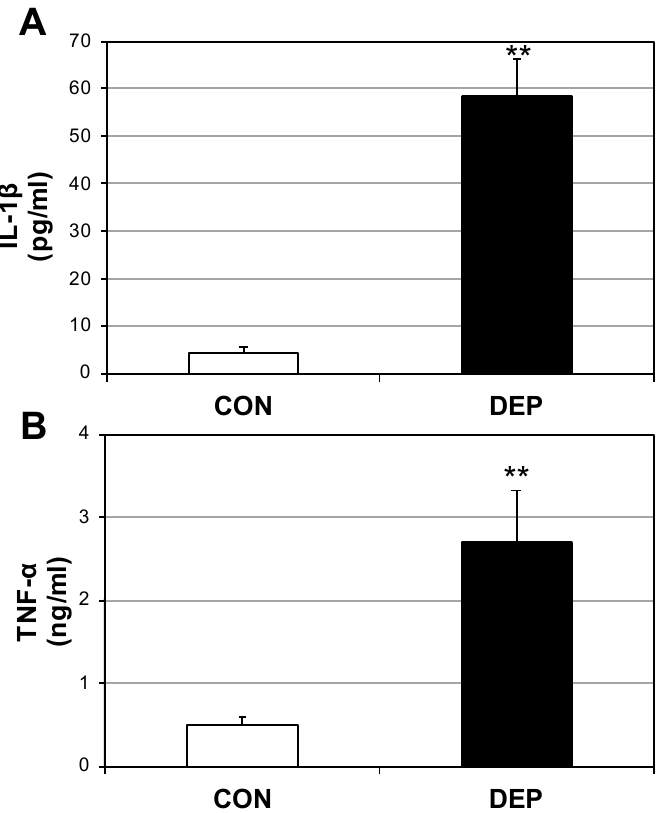
Figure 2. Diesel exhaust particle exposure increases circulating pro-inflammatory cytokines. Following 4 weeks of room air (CON) or diesel exposure (DEP), plasma levels of IL-1 β ( A ) and TNF- α ( B ) were measured from mice. n = 8. ** p < 0.01; CON vs. DEP.